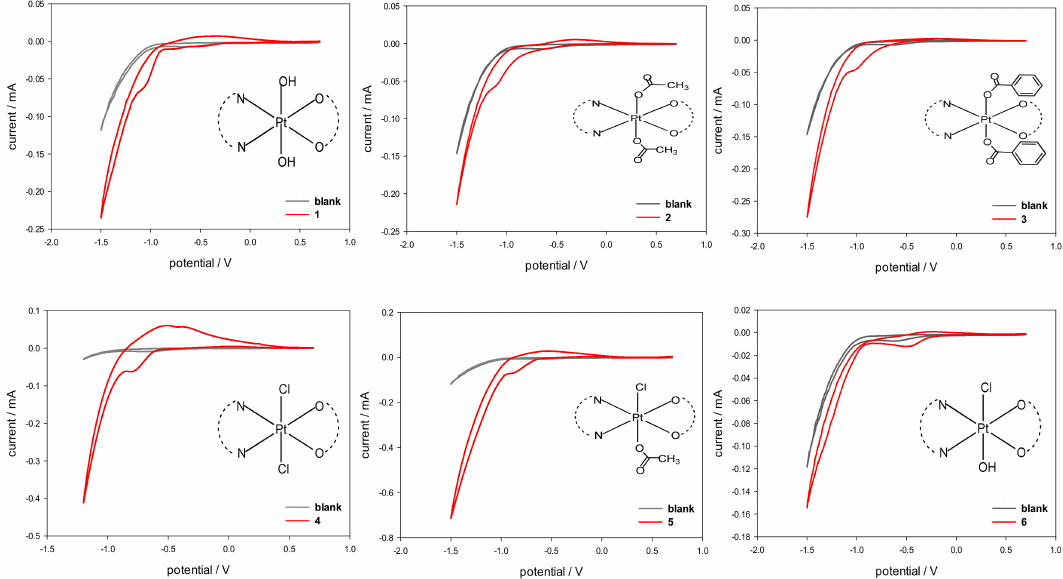
Figure 6. Cyclic voltammograms of Pt(IV) complexes 1 – 6 (red) recorded at a glassy carbon electrode in bu ff ered aqueous solution (PBS, pH = 7.4, I = 0.1) containing 5 mM NaCl as supporting electrolyte and 5 · 10 − 4 M Pt(IV) complex. Scan rate 20 mVs − 1 . The CV plot of the blank solution is overlaid in